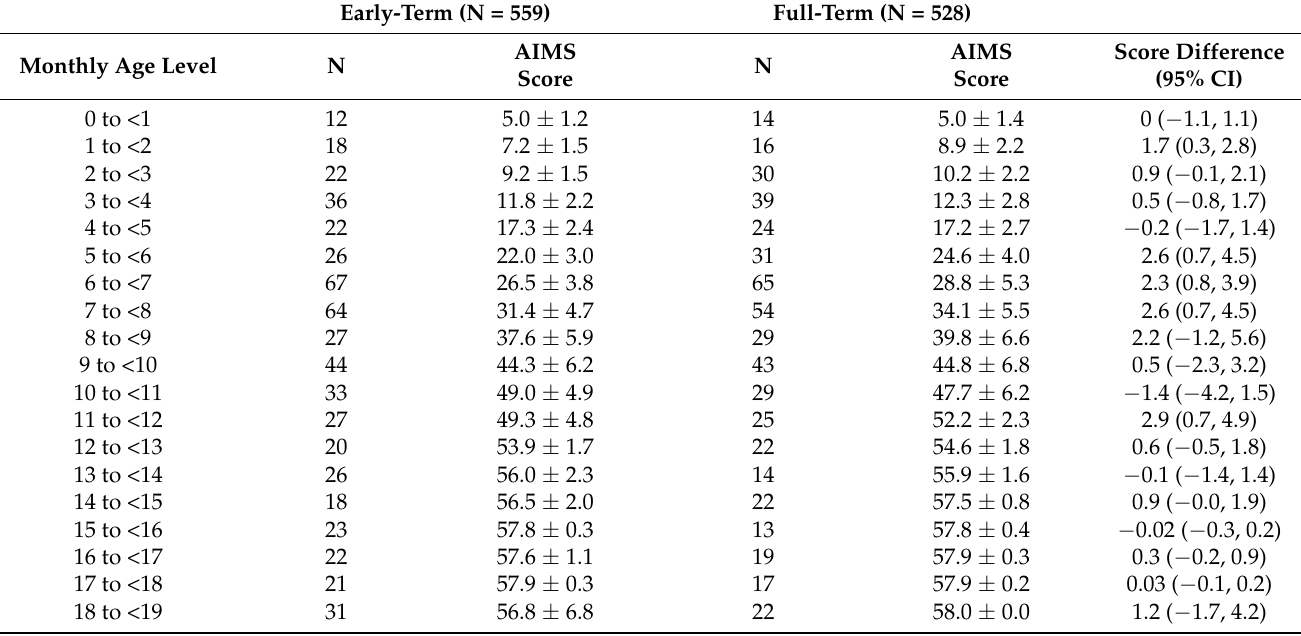
Table 1. Total AIMS scores (mean ± SD) in early-term and full-term infants according to monthly age